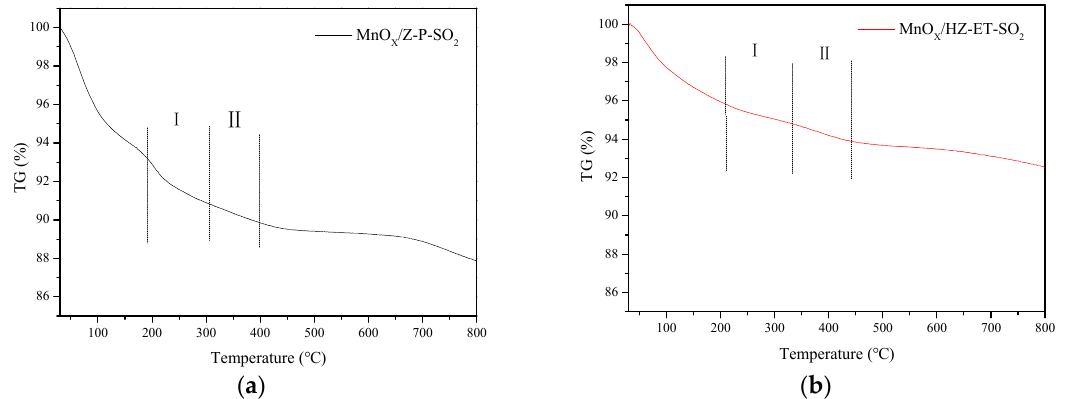
Figure 10. TG profiles of the catalysts used. ( a ) MnO x /Z-P-SO 2 , ( b ) MnO x /HZ-ET-SO 2 .